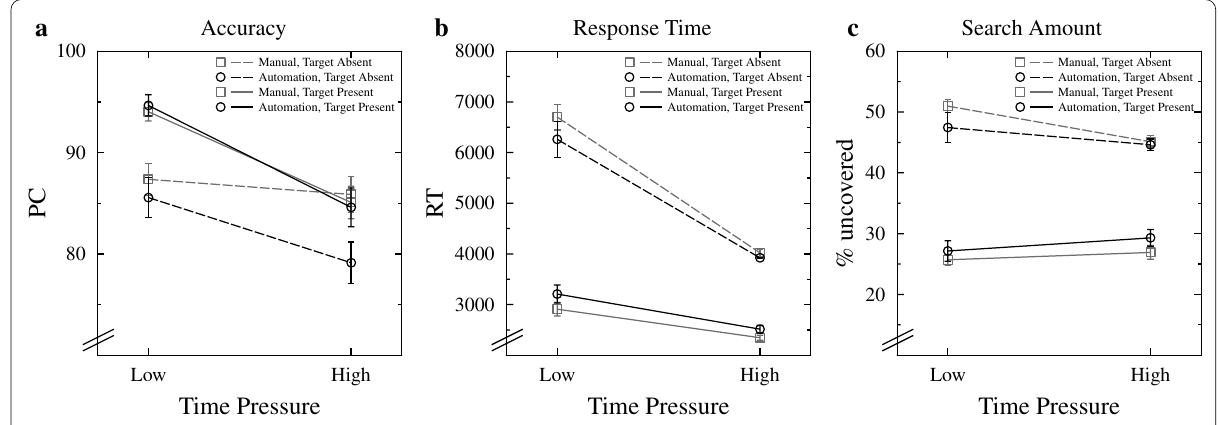
Fig. 2 Data for percent correct ( a ), response times ( b ), and search amount ( c ), separately for each time-pressure condition, as a function of automation condition and target presence. Error bars represent standard errors of the mean. PC: percent correct, RT: response